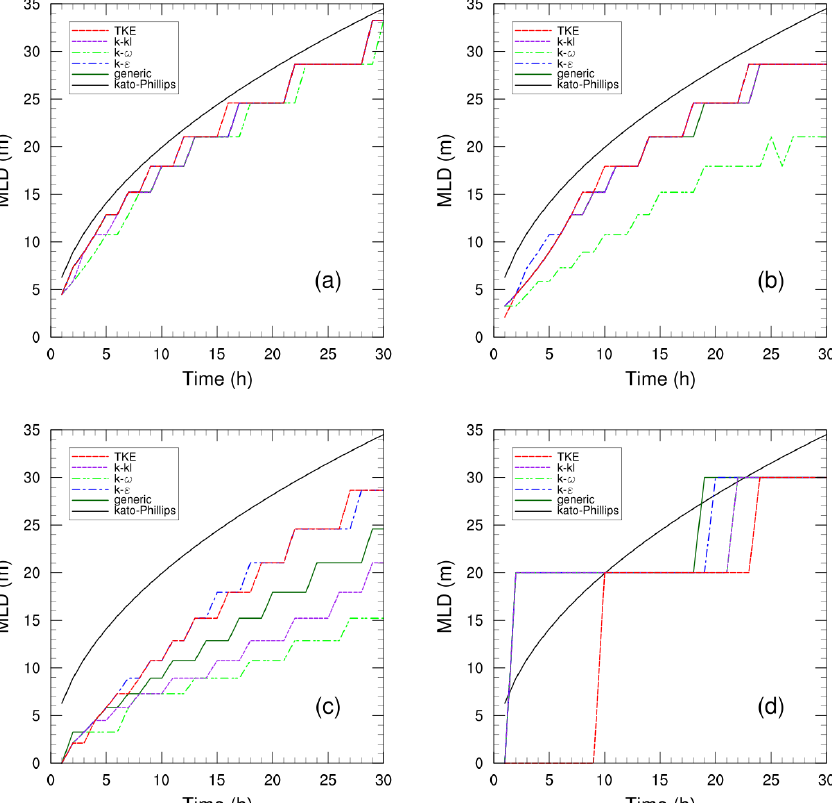
Figure 3. Time evolution of the MLD obtained with the different turbulence models for the pairs [L75, 360s] (a) , [L75, 1200s] (b) , [L75, 3600s] (c) , [L31, 3600s] (d) .